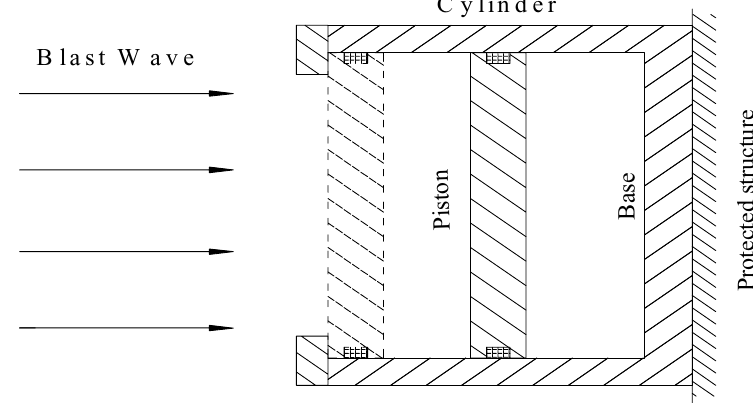
Fig. 1. Schematic of the blast wave mitigation device.